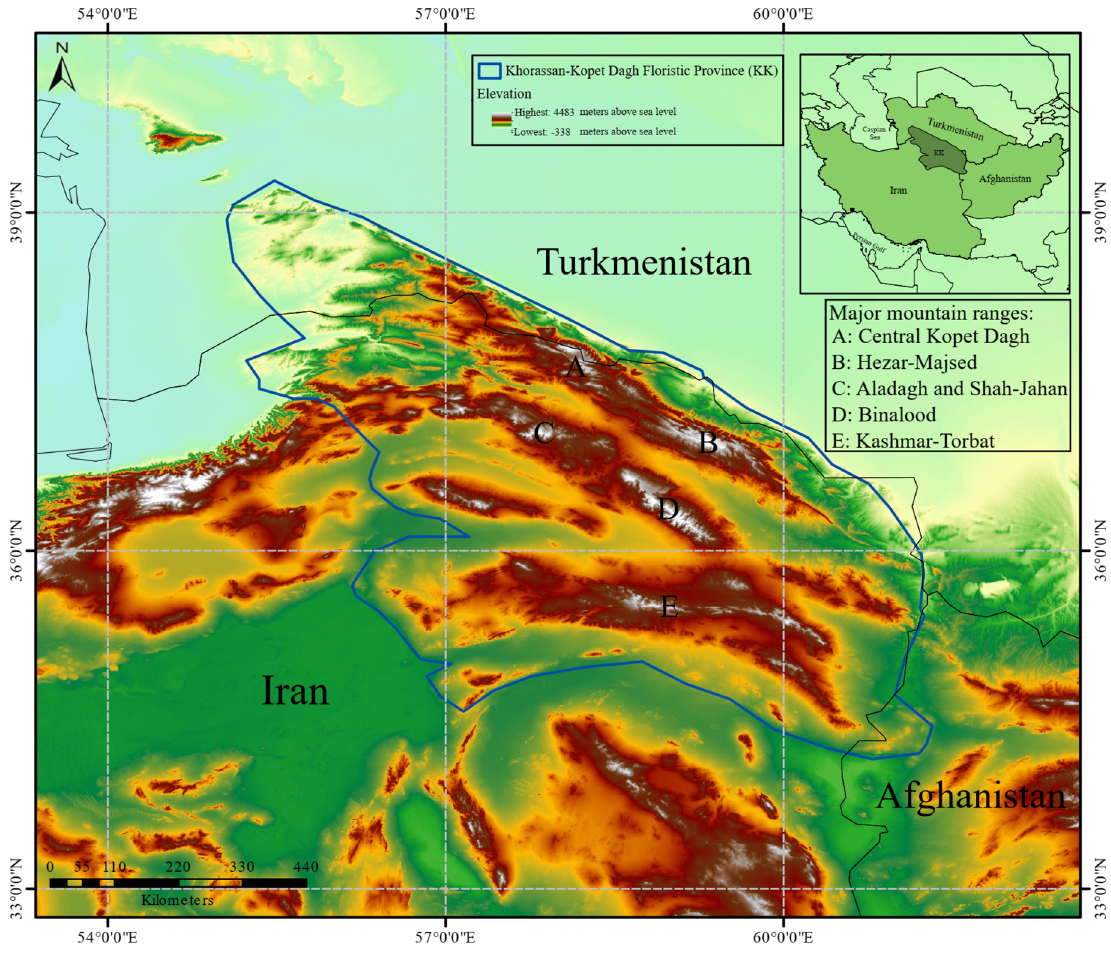
Figure 1. Study area—the Khorassan-Kopet Dagh floristic province (KK). The elevation range reported in the legend is for the entire map and not corresponds to the elevation range of KK. The original figure was adopted from Ref. 14